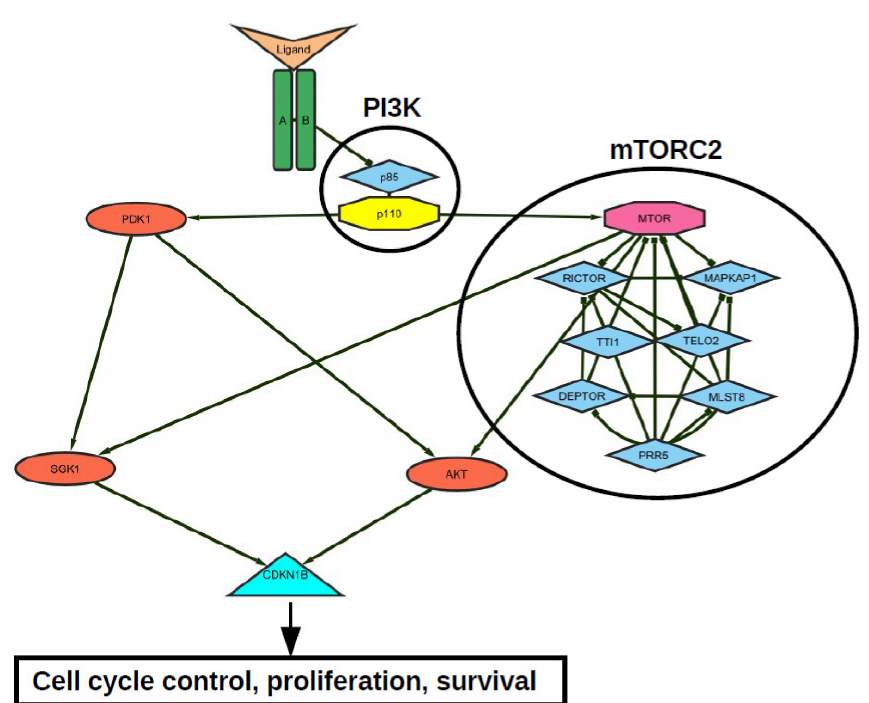
Figure 2. Representative receptor tyrosine kinase—mTORC2—PI3K—AKT—SGK1 signal network. Both AKT- and SGK-mediated CDKN1B (p27) T157 phosphorylation opposes p27-mediated G1 arrest and thus increases proliferation, survival and tumor